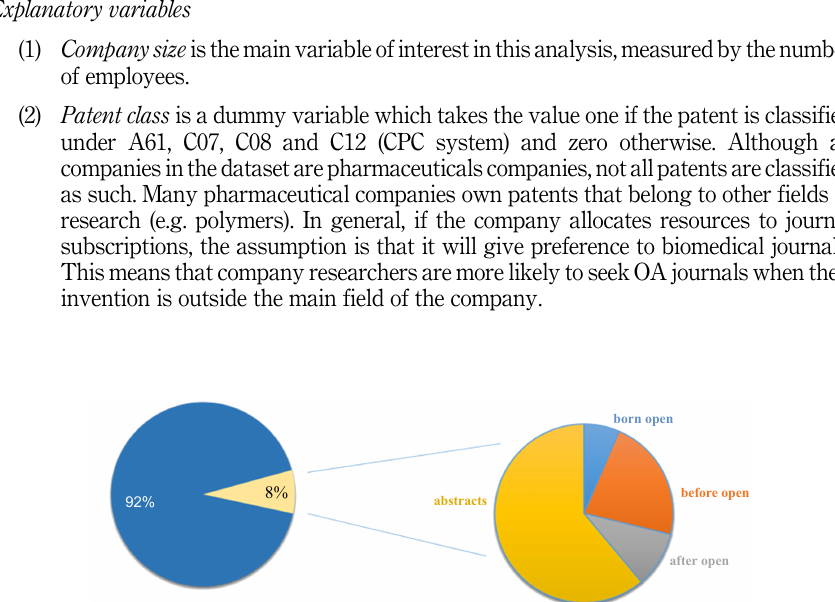
Figure 1. Breakdown of OA citations in the NPL section of pharmaceutical